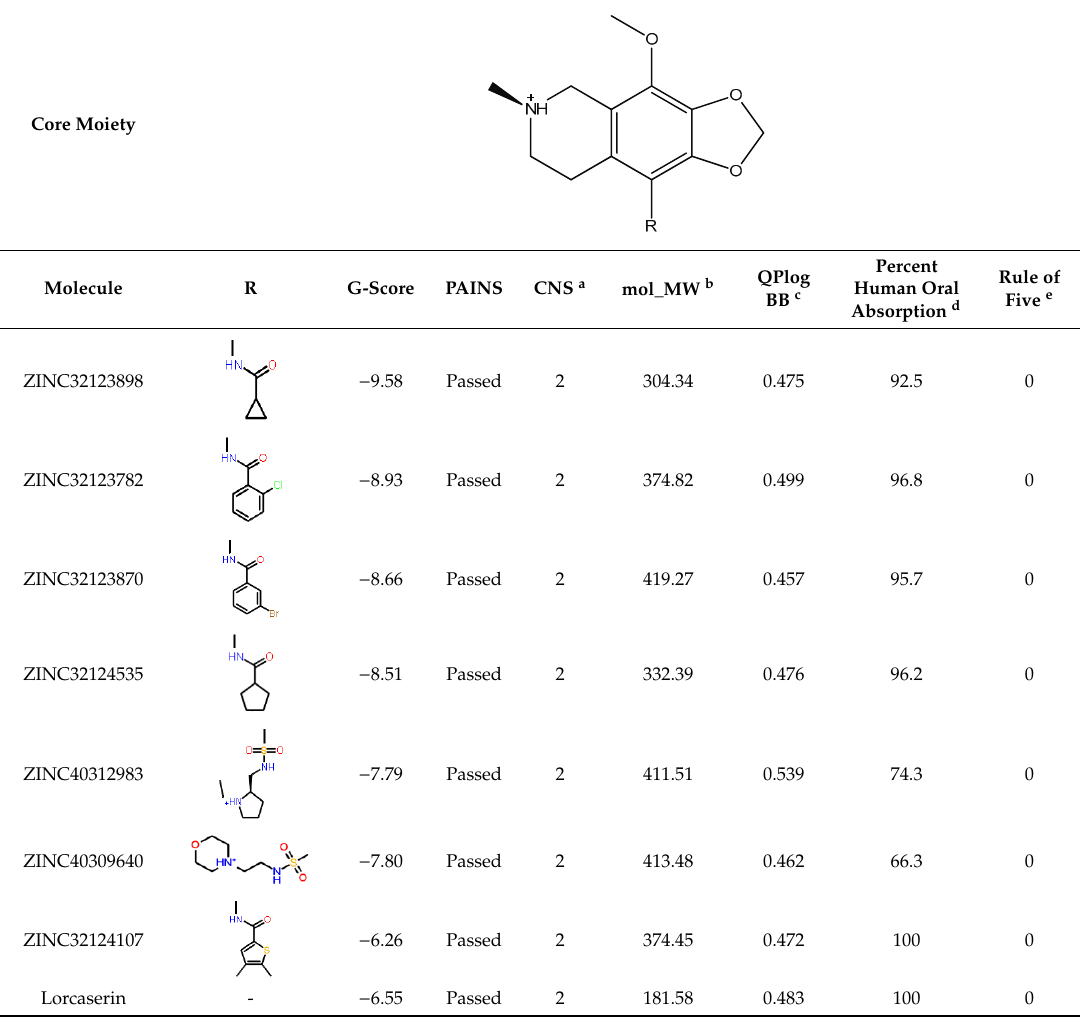
Table 2. Docking scores of potential hits and their pharmacological properties.